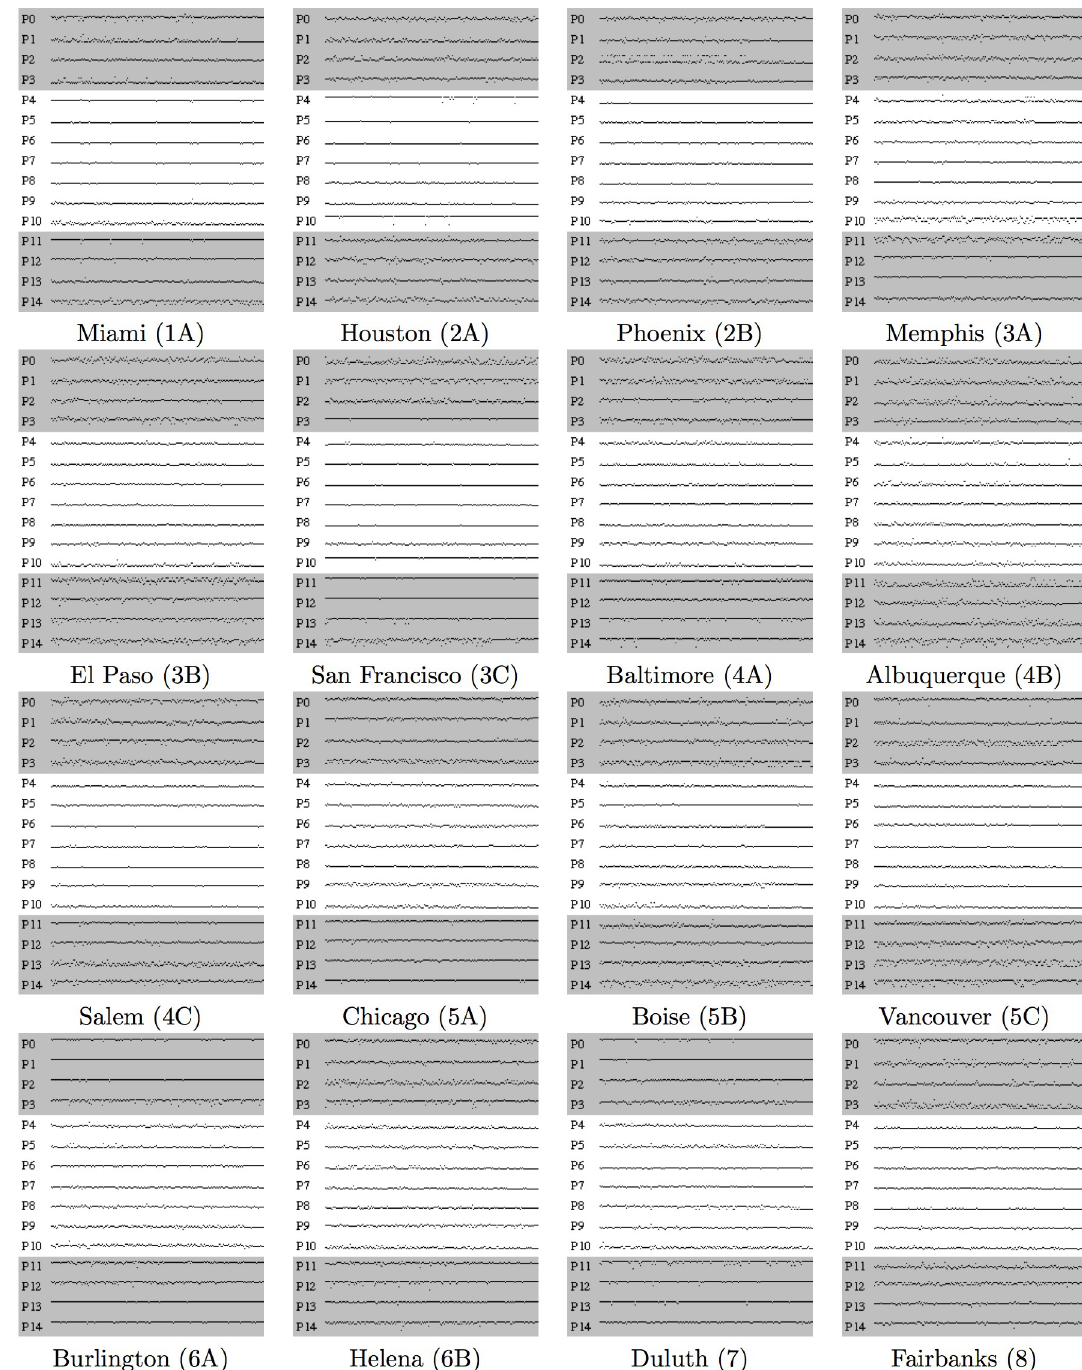
Fig 2. Positions of control points of the best 200 candidate solutions found by genetic optimisation for each model location. Solutions are ordered from left to right in decreasing order of total equivalent source energy, ESE , with positions of control points indicated in labeled rows. Position of each control point is indicated by height of the appropriate pixel, with the highest position corresponding to value 0 ( × 0.25m), and the lowest position corresponding to value 8 ( × 0.25m).